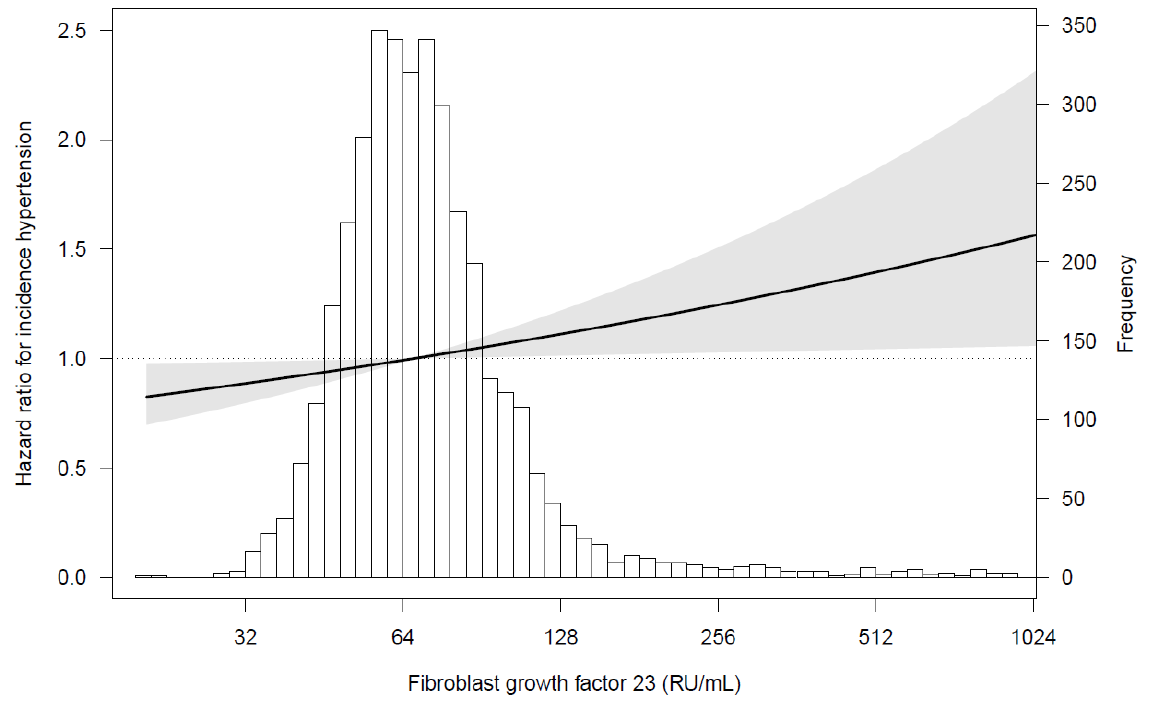
Figure 2. Associations between fibroblast growth factor 23 and incident hypertension in 3720 participants. Data were fit by a Cox proportional hazards regression model adjusted for age, BMI, eGFR, urinary sodium excretion, urinary albumin-to-creatinine ratio, diabetes, smoking, history of cardiovascular disease, anti-diabetic, lipid lowering drugs, PTH, vitamin D, plasma phosphate, plasma corrected calcium, and urinary phosphate excretion. The grey area represents the 95% CI. Abbreviations: eGFR, estimated glomerular filtration rate; BMI, body mass index; PTH, parathyroid hormone.